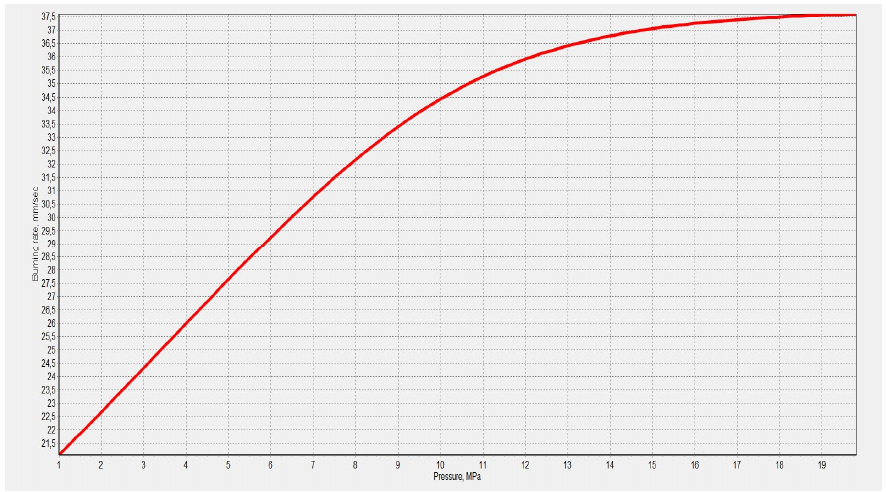
Figure 5. A representative dependence of burning rate on pressure for the case 2 in Table 1. Table 1. Examples of results of calculation of the ANN MCM that solves the direct task.